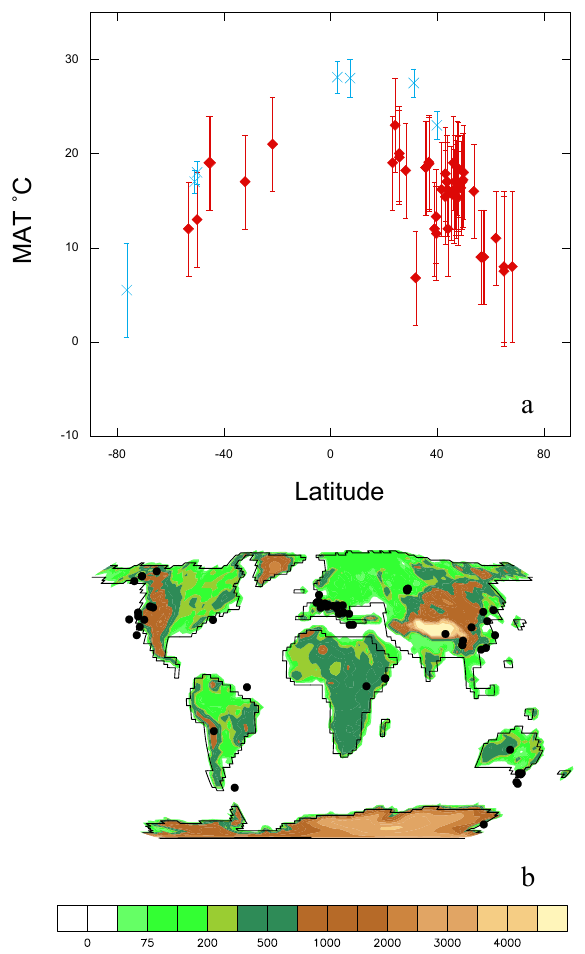
Fig. 1. (a) Longitudinal distribution of MMCO terrestrial temper- atures (red diamonds) and SST (blue crosses) with proxy record error plotted as the vertical bars and described in Tables S1 and S2. Fig. XX a) MMCO terrestrial temperatures (red diamonds) and SST (blue (b) The spatial distribution of the terrestrial and SST proxy records crosses) with methodological error plotted as the vertical bars and described in used in the model–data comparisons overlain onto the Miocene to- Table S1,S2. b) The spatial distribution of the terrestrial and SST proxy records pography (Herold et al., used in the model data comparisons overlain onto the Miocene topography (Herold et al., 2008).